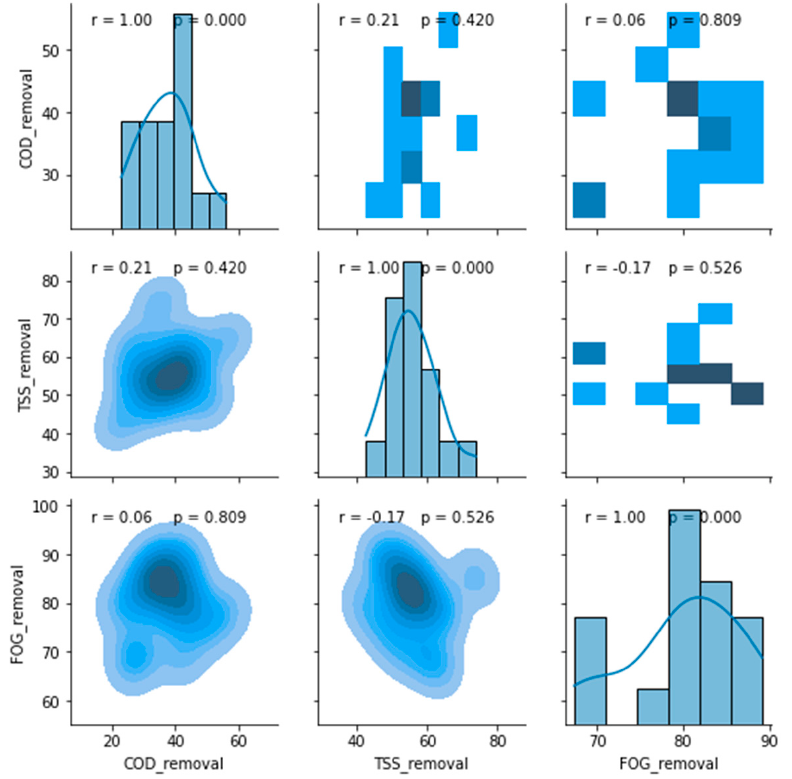
Figure 10. Correlation matrix between removal efficiencies of the pre-treatment stage.